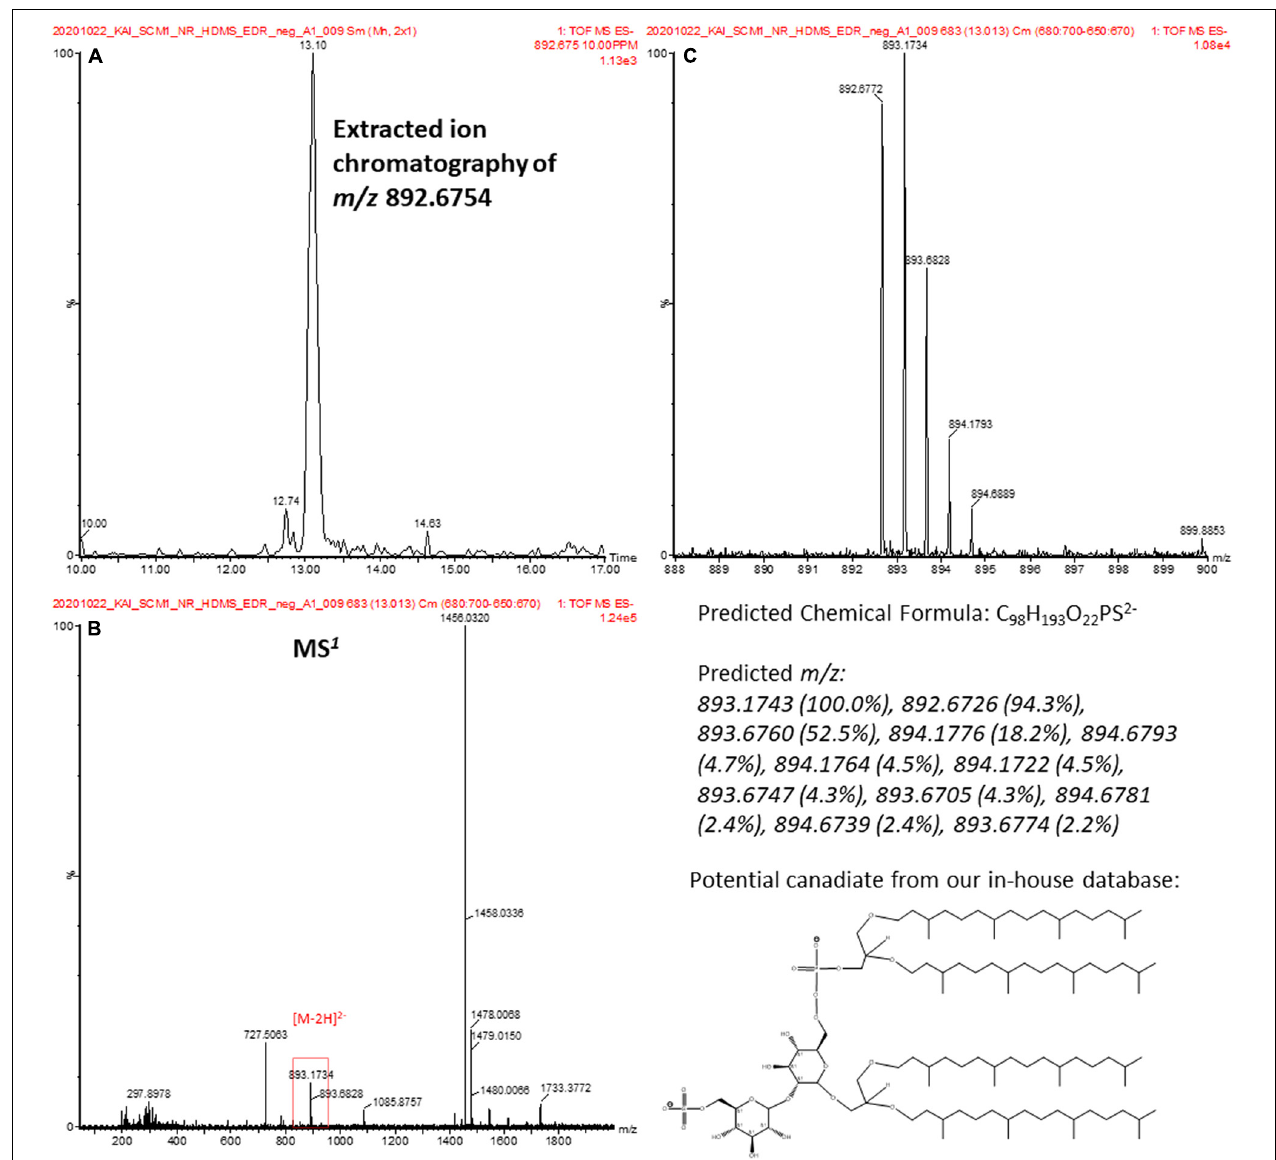
FIGURE 9 | (A) EIC confirms a detection of a spectral feature at 13.1 min. (B) The MS 1 spectrum of the spectral feature in (A) . (C) The isotopic pattern of the doubly charged ion at m / z 892.2754 in (B) and is consistent with the predicted pattern of a candidate lipid, 2-(6 (cid:48) -sulfo- β -D-mannosyl)-6-archaetidyl- α -D-glucosylarchaeol, in our